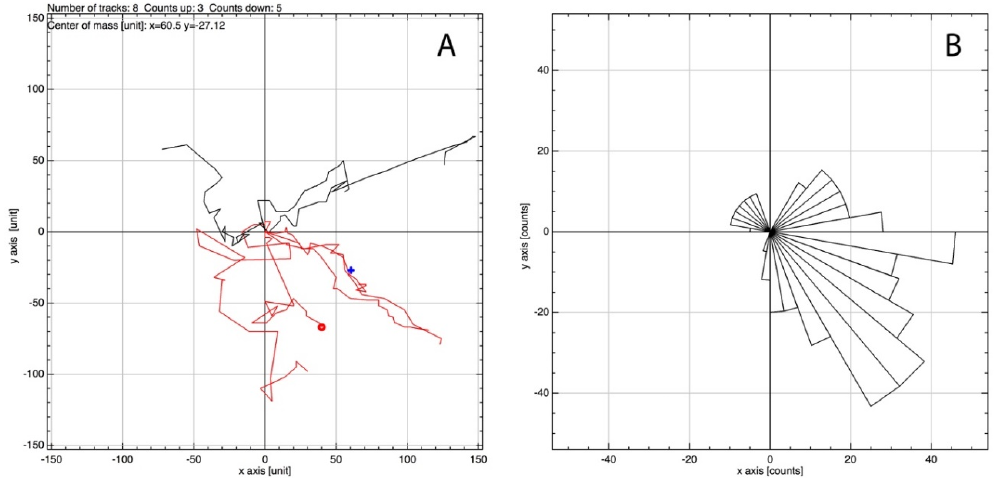
Figure 3. Analysis of images generated during the 24 h MSC time ‐ lapse imaging using the manual tracking plugin for ImageJ and the chemotaxis tool provided by Ibidi. IL ‐ 6 containing media was situated toward the positive axis. ( A ) Vector plot based on the tracking of 8 randomly selected cells showing the vector each cell has moved from origin with ( B ) showing the directionality of the cells as a rose plot.